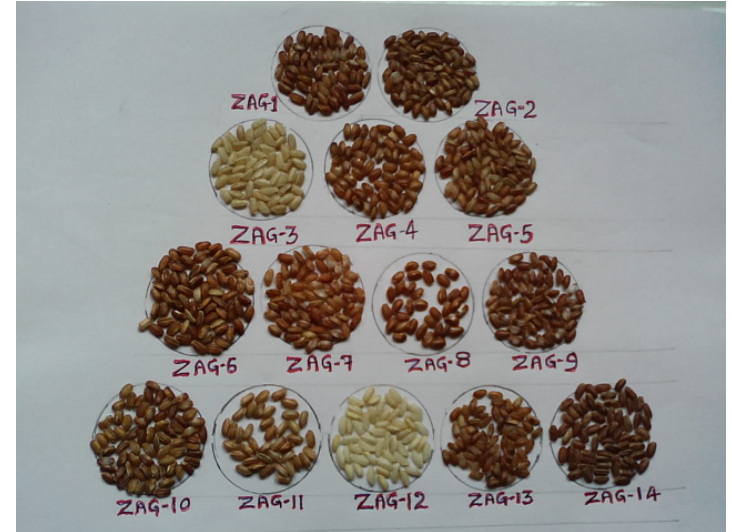
Fig. 1. Variability in pericarp colour intensity among 14 red rice ecotypes from temperate region of Kashmir, India